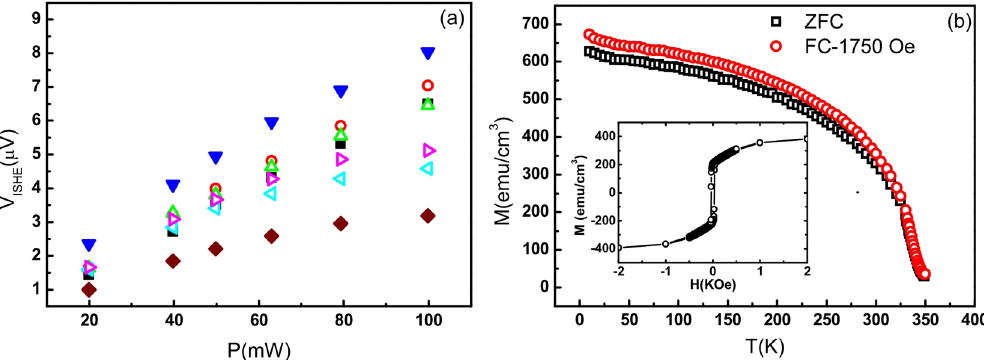
Figure 3. ( a ) Microwave power dependence of V ISHE for the series of LSMO/Pt( t Pt ) bilayers with different t Pt : 4 nm ( ▪ ), 6 nm ( ○ ), 8 nm ( Δ ), 11 nm ( ▾ ), 17 nm ( ◁ ), 21 nm ( ▷ ) and 30 nm ( ◆ ). ( b ) Field-cooled and zero-field- cooled magnetization vs. temperature for LSMO(20 nm)/Pt(6 nm). The inset shows the room-temperature hysteresis loop of the